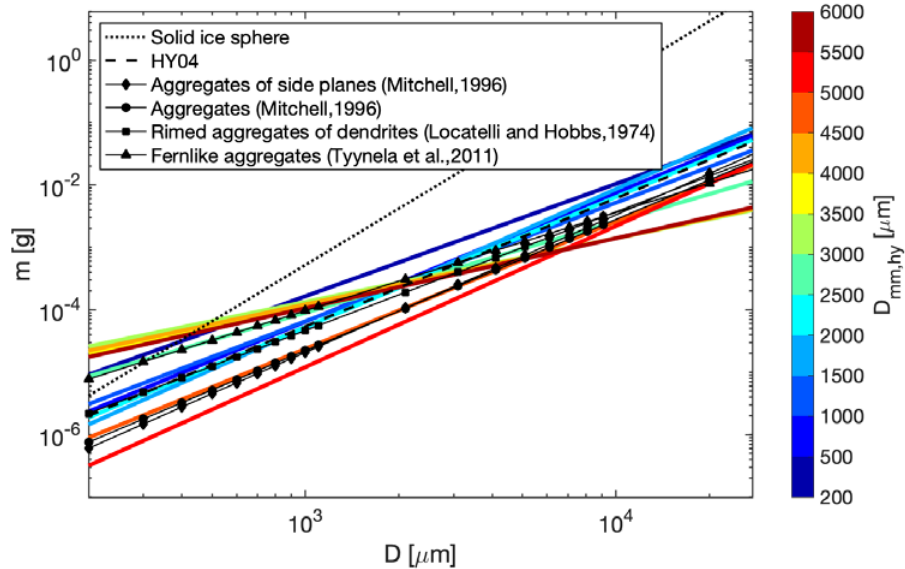
Figure 6. Single particle mass derived from different m–D relations. Colored solid lines are the single particle masses derived from the best estimates of ( a , b ) in Figure 2 for different D mm,hy ranges indicated by the color bar.